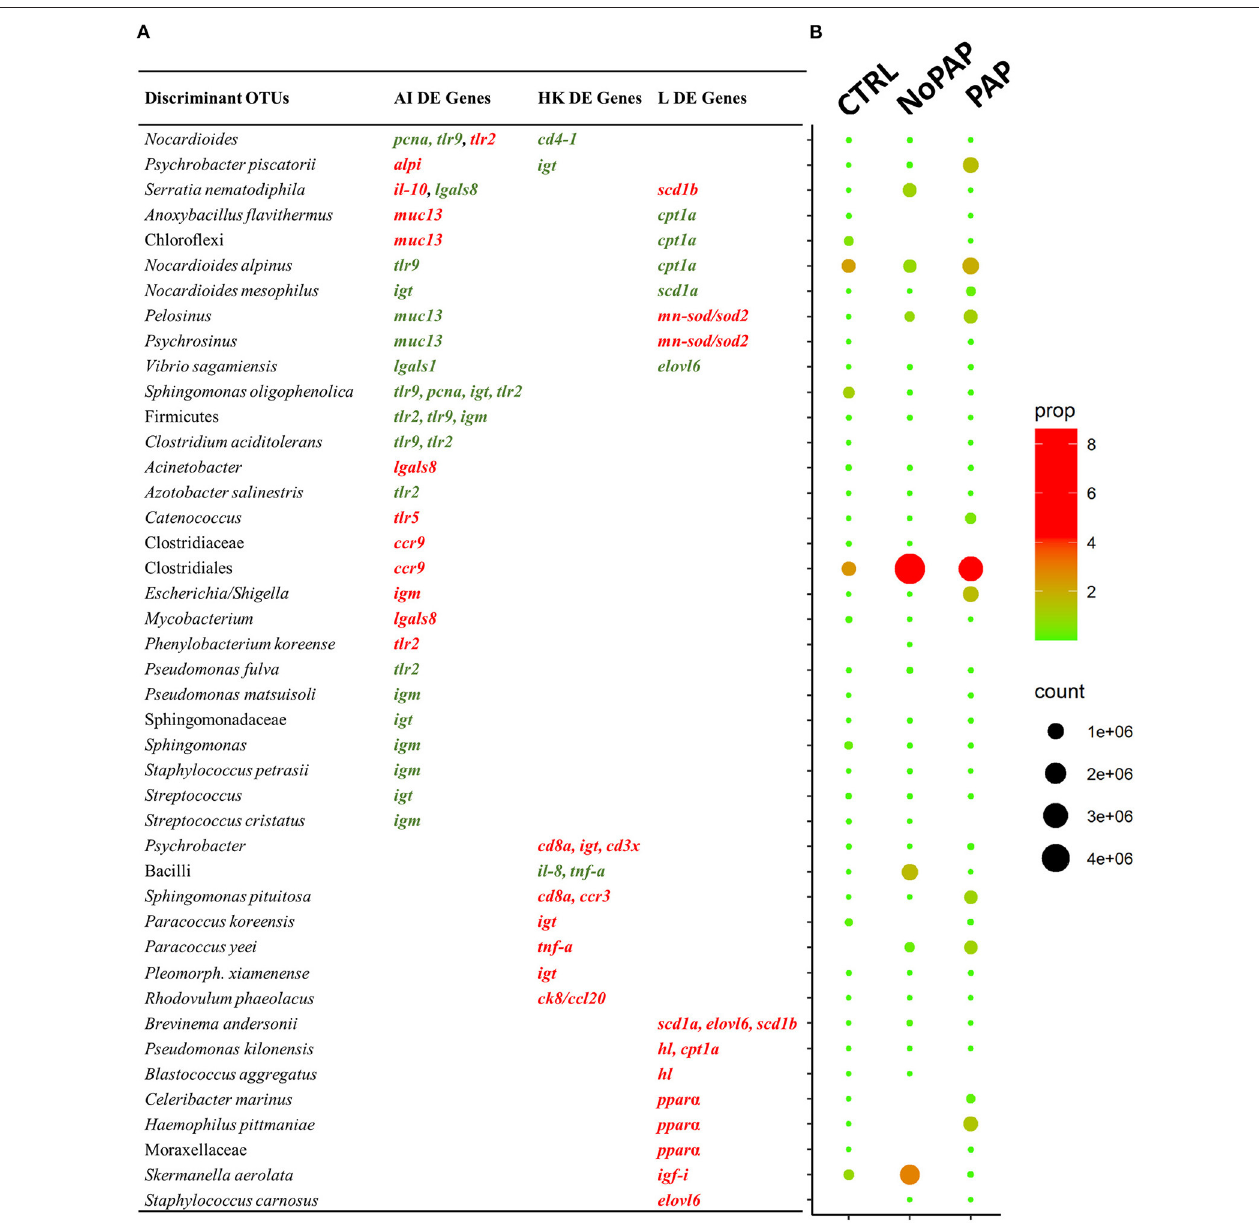
FIGURE 6 | (A) List of the 43 discriminant OTUs involved in significant ( P < 0.01) correlations with intestinal (AI), head kidney (HK), and liver (L) differentially expressed genes (DEGs). Colors of genes in DE gene columns indicate if there is a direct (red) or inverse (green) OTU-gene correlation. (B) Dot plot depicting the normalized count number together with the proportion of correlated OTUs among the CTRL and experimental diets.